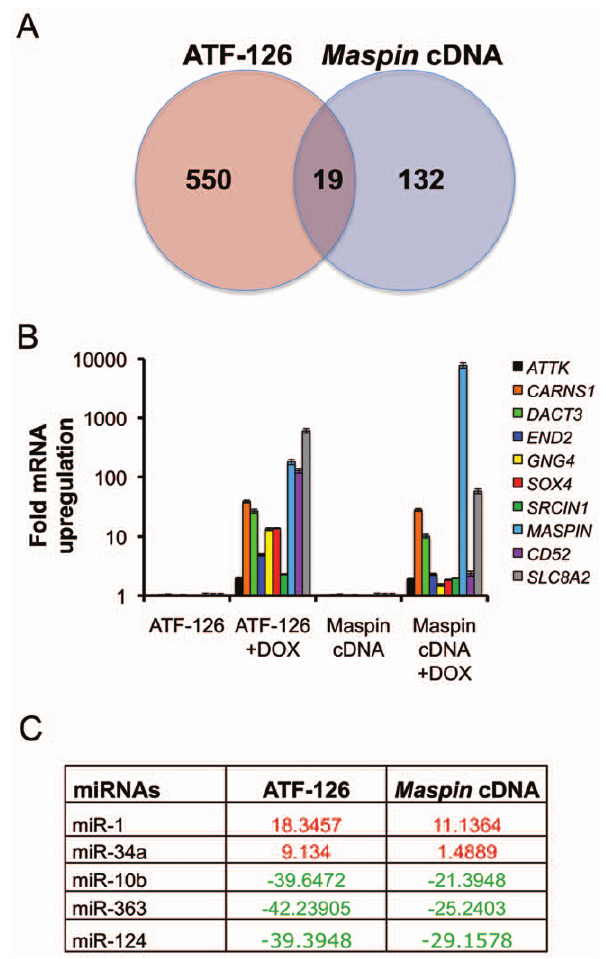
Figure 6. ATF-126 and Maspin cDNA co-regulated targets. A. Venn diagram indicating the intersecting up-regulated genes between the ATF-126 and the Maspin cDNA groups in DOX induced cells. B. Gene expression analyses of nine differentially up-regulated genes. The ATF-126 and Maspin cDNA stable cell lines were treated with either vehicle ( 2 DOX) or DOX ( + DOX) for a period of 72 hrs, and differences in expression quantified by qRT-PCR. Data was normalized to the 2 DOX cells, and represent an average of three independent experiments. C. Common MicroRNAs differentially regulated in the ATF- 126 and the Maspin cDNA cell lines, as assessed by qRT-PCR. Data was normalized to the 2 DOX cells. Up-regulated miRNAs are indicated in red, and down-regulated miRNAs in green.